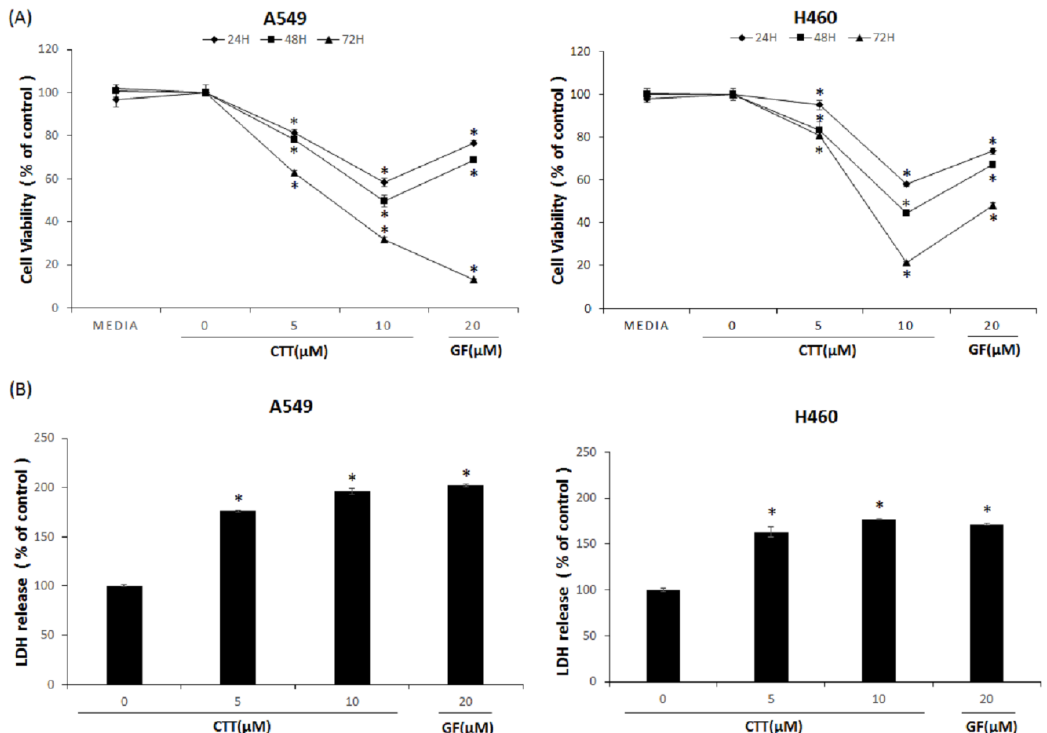
Figure 1. Effects of CTT treatment on cytotoxicity in A549 and H460 cells. ( A ) Cell viability was evaluated through MTS assay after 24, 48, and 72 h treatment with 0, 5, or 10 μM of CTT or 20 μM GF (clinical anticancer drug). * p < 0.05 compared to the control group. ( B ) LDH release was assessed using an LDH assay kit after 24 h treatment with 0, 5, or 10 μM of CTT or 20 μM GF (clinical anticancer drug). * p < 0.05 compared to the 0 μM of CTT group. The data represent each of the three independent experiments. Significant differences for the treated groups were determined by Duncan’s test for multiple comparisons. Values are represented as the mean ± SD from each